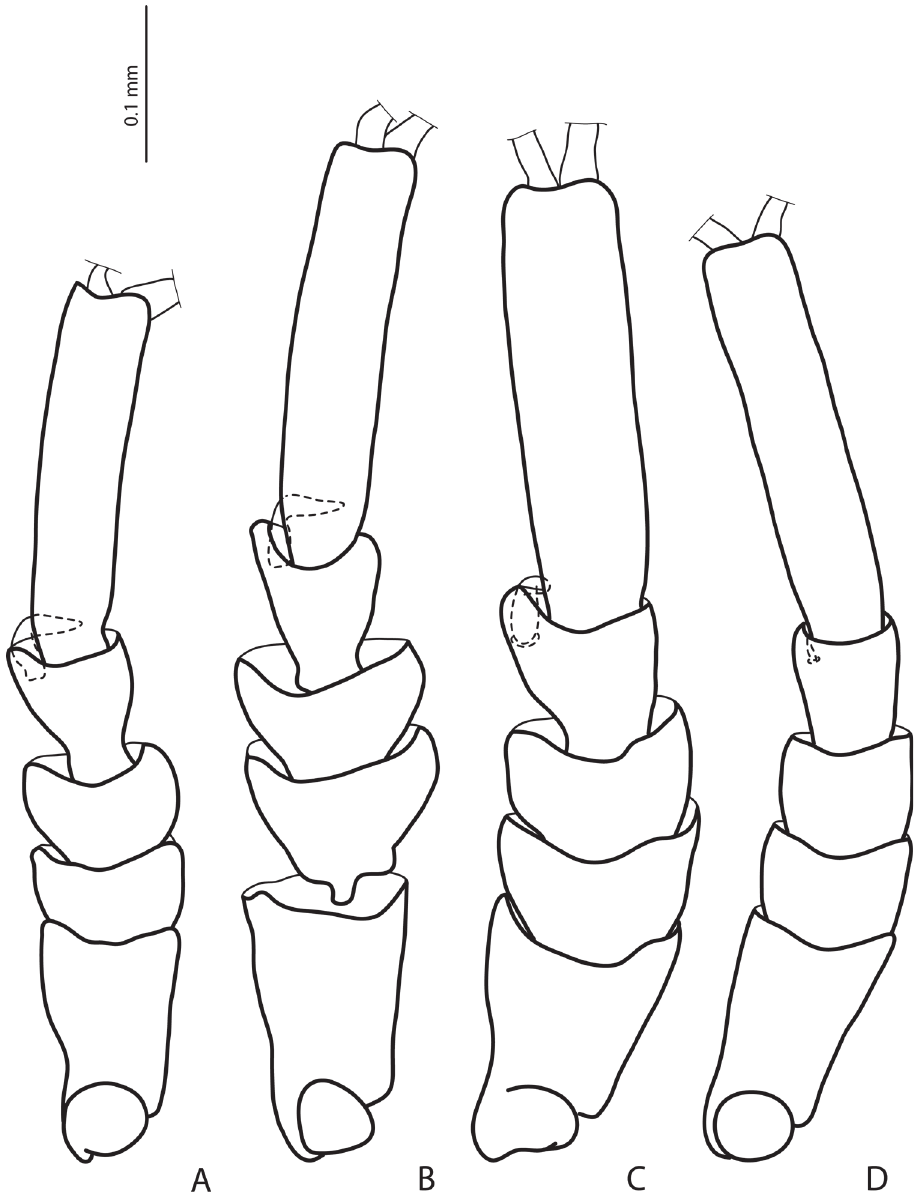
Figure 2. Male protarsomeres 1–5 in dorsal view A Exocelina baliem sp. n. B E. ferruginea (Sharp, 1882) C E. ullrichi (Balke, 1998) D E. knoepfchen Shaverdo, Hendrich, Balke, 2012. coxosternites similar to those of E. vladimiri Shaverdo, Sagata & Balke, 2005 (see Fig. 17a in Shaverdo et al. 2005). Gonocoxae with prolonged, slightly pointed apices and sparse setation, without setae on inner margin in ventral view (Fig.